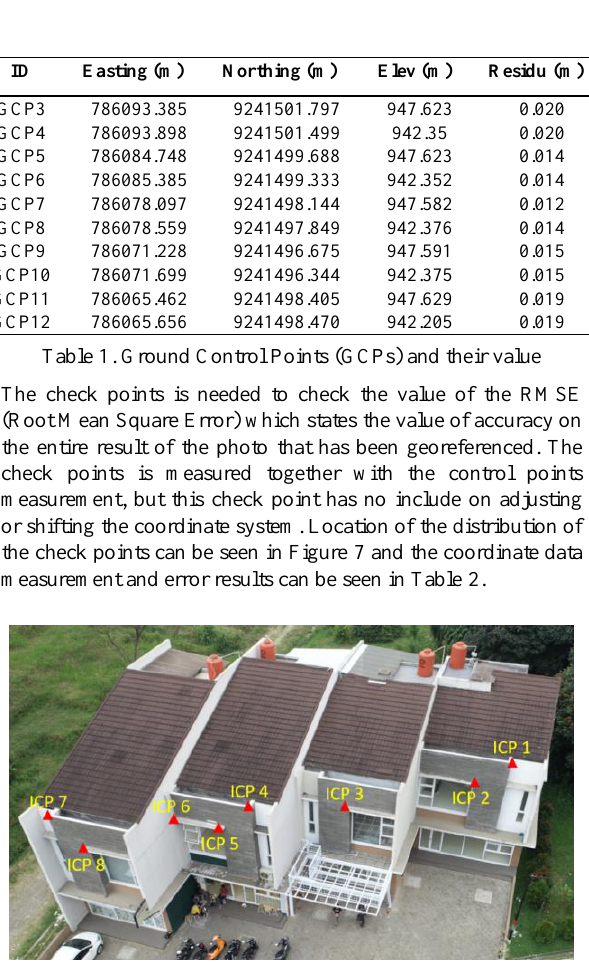
Figure 7. Check Points (ICPs) location distribution